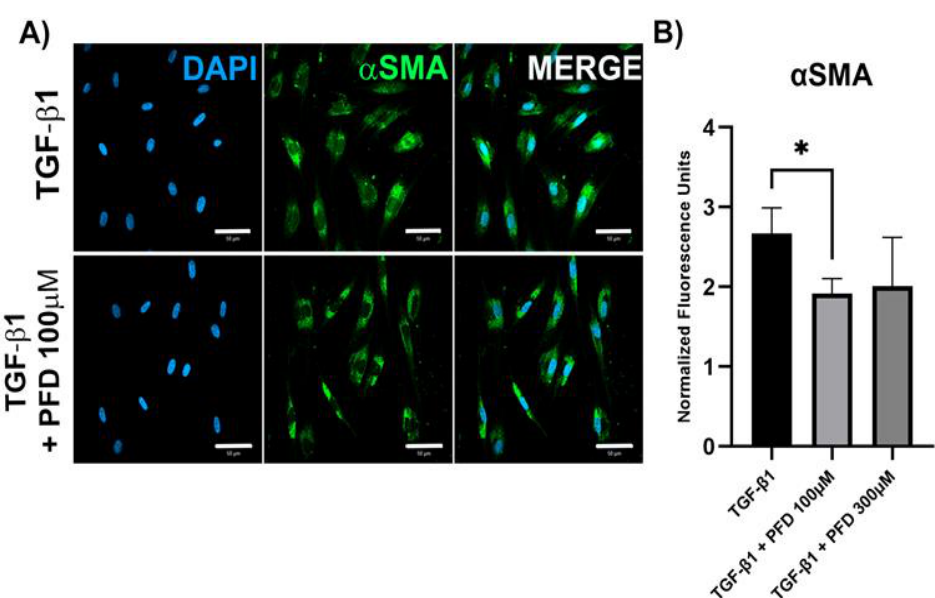
Figure 3. Analysis of αSMA protein expression by immunofluorescence in primary HCF cell culture in response to treatment with TGF- β and pirfenidone. HCF cells were stimulated with TGF- β for 24 h in presence or absence of PFD at 100 µM. ( A ) Immunofluorescence images obtained by confocal microscopy. Scale bar 10 µm for all panels. ( B ) Semi-quantification by fluorescence intensity analysis. Data expressed as mean ± standard deviation. αSMA, α smooth muscle actin; DAPI, 4′,6 -diamidino-2-phenylindole; TGF- β, transforming growth factor - β; HCF, human corneal fibroblast; PFD, pirfenidone. * p < 0.05.